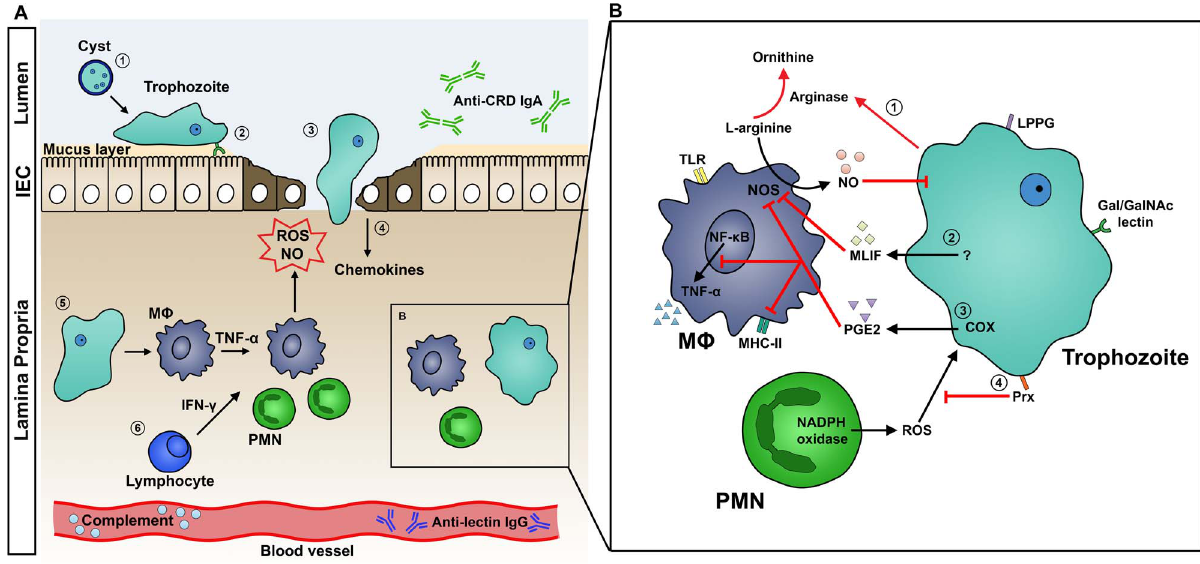
Figure 1. A. Host Immune Response to Intestinal Amebiasis. (1) Stomach acid serves as a first line of defense against enteropathogens, but amebic cysts are highly resistant and excyst in the lumen of the intestine. (2) Mucin, a glycoprotein secreted by goblet cells and submucosal glands, is the main constituent of the protective mucus layer. Trophozoites attach to the host tissue surface via Gal/GalNAc lectin. (3) Amebae secrete cysteine proteases, which disrupt the mucus layer and facilitate tissue invasion. (4) Injured IECs release potent chemokines to recruit immune cells to the site of invasion. (5) Activated macrophages release TNF- a , stimulating PMNs and macrophages to release ROS and NO, which kill the parasite. ROS and NO may also contribute to tissue destruction. (6) IFN- c released by lymphocytes activates macrophages and PMNs. B. Mechanisms of Host Immune Evasion. (1) E. histolytica trophozoites inhibit the respiratory burst of M W using arginase, which converts L-arginine, a substrate of NOS, to L- ornithine. This depletes the L-arginine supply that macrophages use to produce NO. (2) MLIF produced by ameba suppresses NO production. (3) COX in ameba or ameba-exposed macrophages produces the immunoregulatory molecule PGE2. PGE2 suppresses macrophage effector functions by elevating cAMP levels, which in turn inhibits NO production, MHC-II expression, and TNF- a production. (4) Amebic Prx, a 29-kDa surface protein, confers resistance to neutrophil reactive oxygen species. Abbreviations: COX, cyclooxygenase; IEC, intestinal epithelial cells; IFN- c , interferon-gamma; M W , macrophage; MHC-II, major histocompatibility complex class 2; MLIF, monocyte locomotion factor; NO, nitric oxide; NOS, nitric oxide synthase; PGE2, prostaglandin E2; PMN, polymorphonuclear leukocytes; Prx, peroxiredoxin; ROS, reactive oxygen species; TNF- a , tumor necrosis factor-alpha.